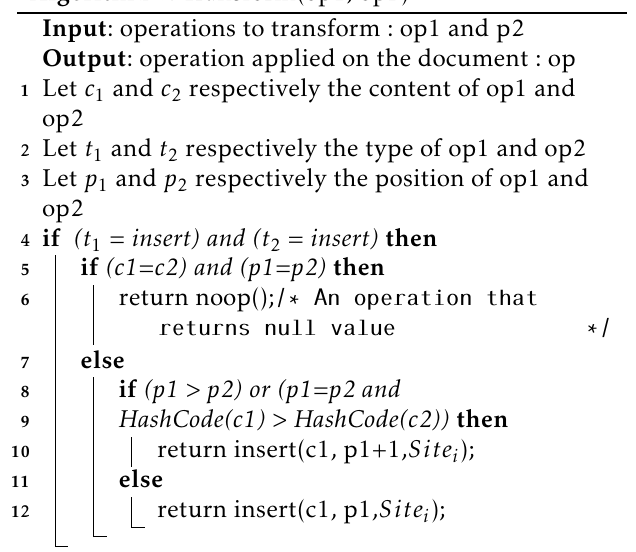
Algorithm 2 : Transform(op1, op2)